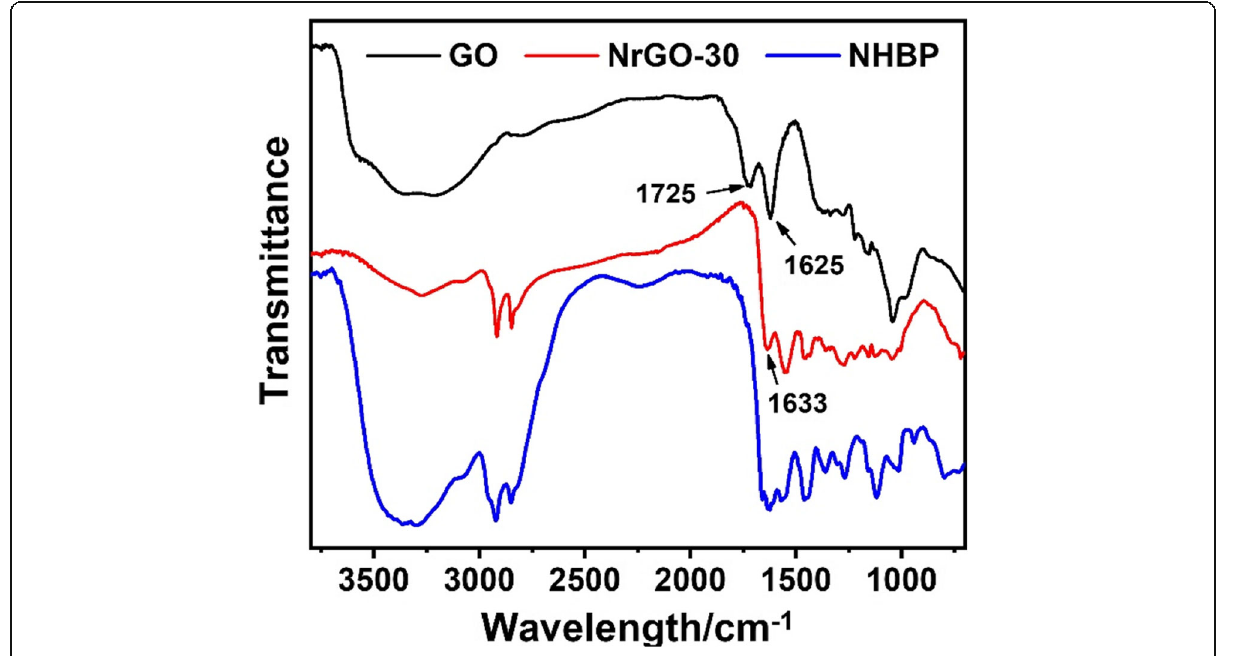
Fig. 3 FT-IR spectra of GO, NrGO, and